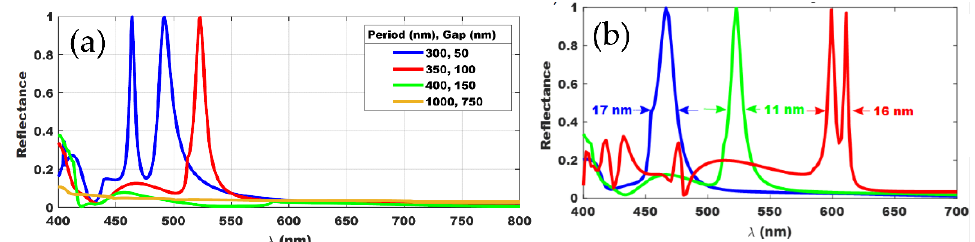
Figure 3. ( a ) Variation in the reflectance from a TiO 2 disk resonator (radius = 200 nm, height = 125 nm) array with changing period (or with changing gap between the neighboring resonators). ( b ) Red (R), green (G) and blue (B) reflectance profiles generated in a TiO 2 disk resonator array. Periodicities chosen to generate R, G, B reflectance colors were 400, 350 and 300 nm, respectively and the corresponding disk radii were 190, 125 and 95 nm. The reflectance peaks are narrow, resulting in a minimum penalty in the transmittance.